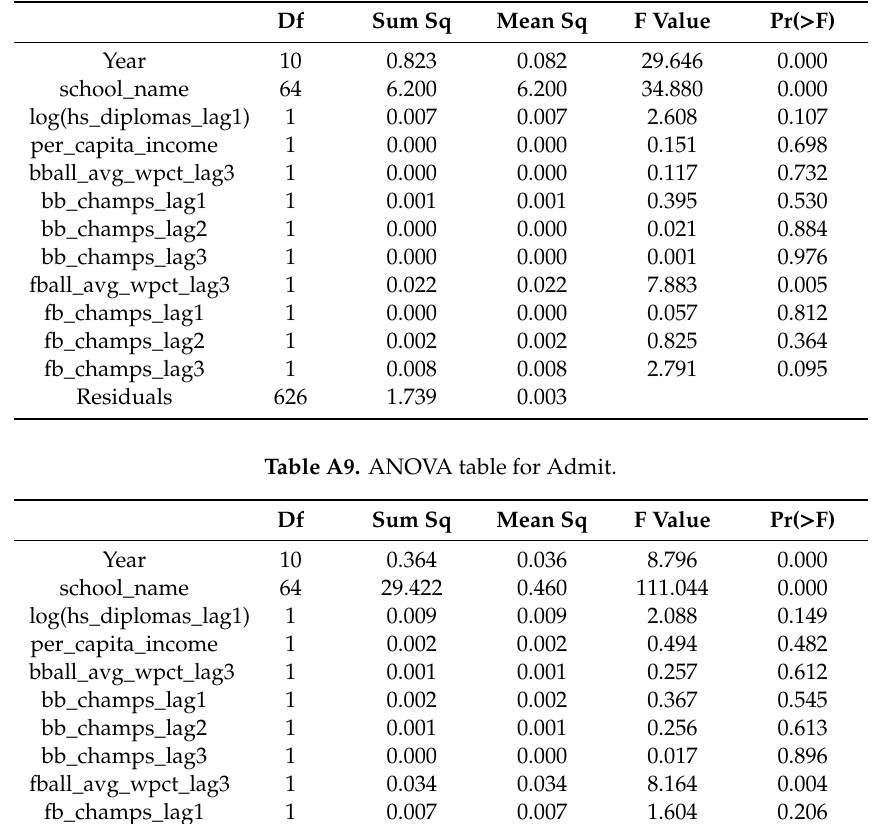
Table A8. ANOVA table for Yield.